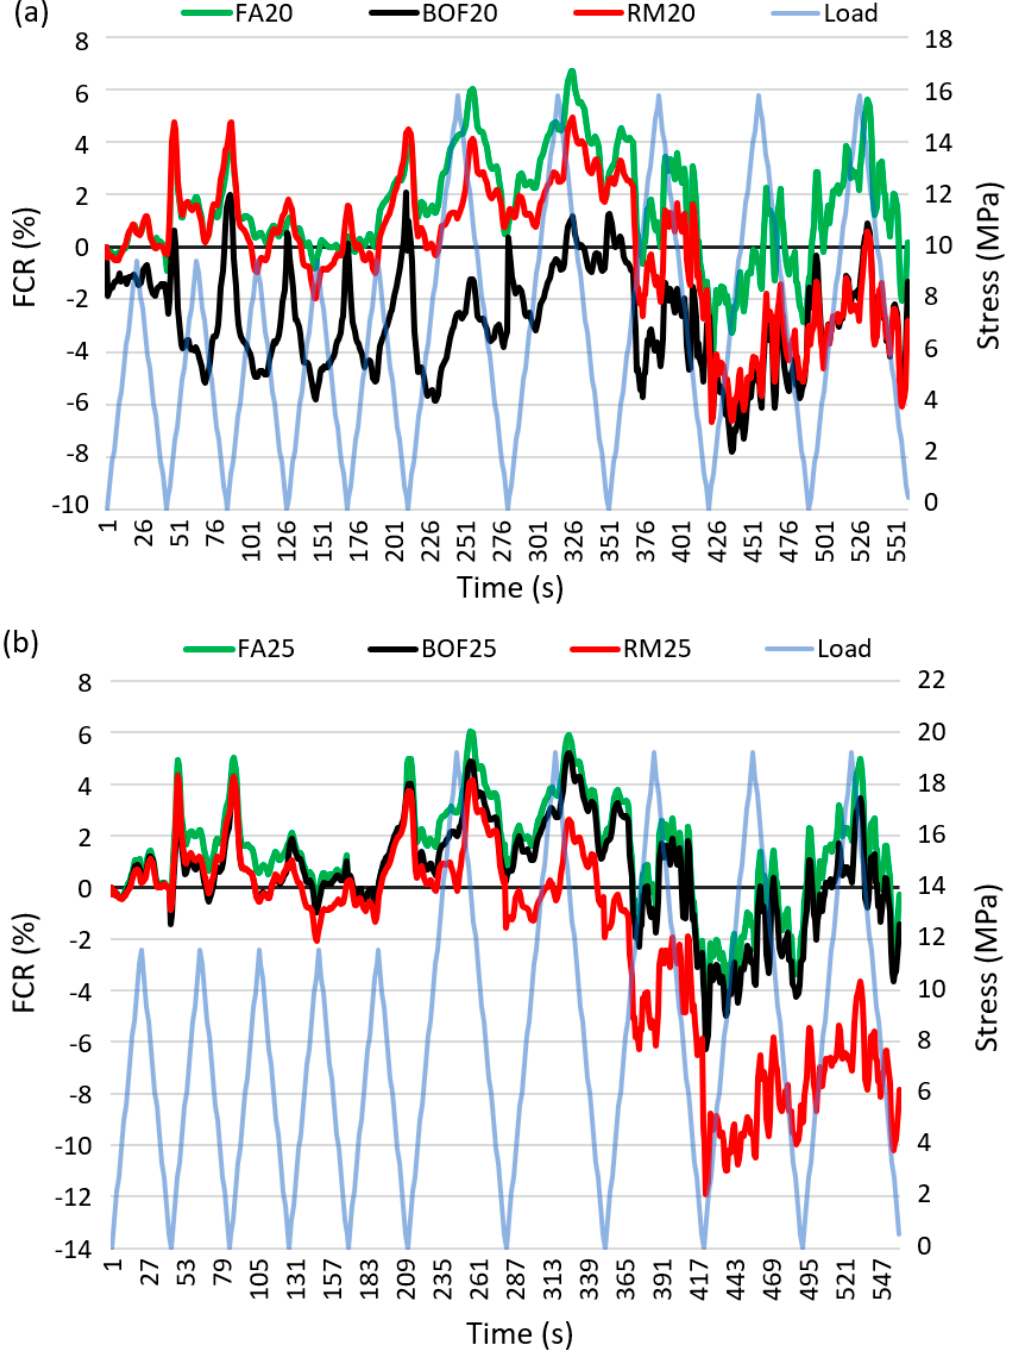
Figure 10. Fractional change of resistivity (FCR) under cycle loadings: ( a ) with 20% of byproduct waste ( b ) with 25% of byproduct waste.